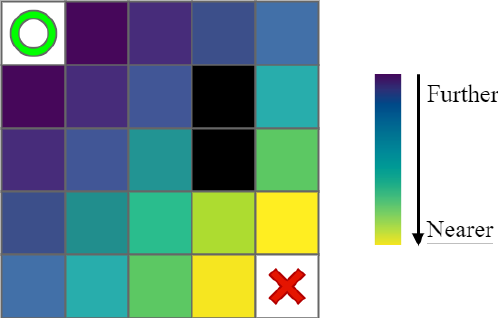
Figure 3. Prior knowledge based on Euclidean